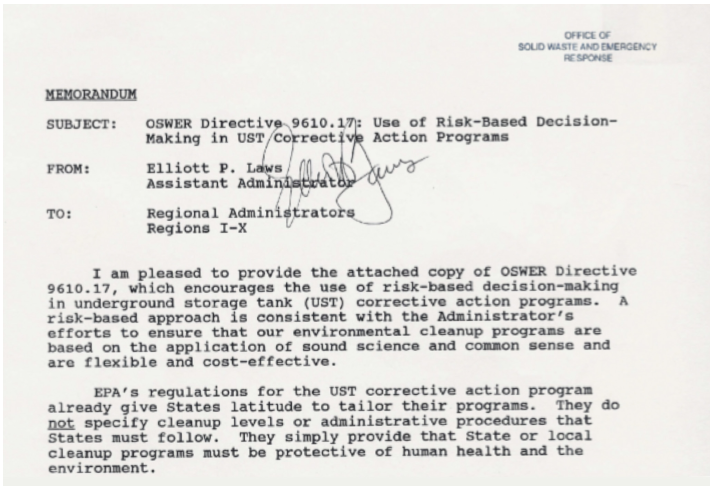
Figure 2. EPA’s letter encouraging (but not requiring!) the use of RBCA (US EPA, 1995). This document endorses a probability-based concept and refers to it as “sound science and common